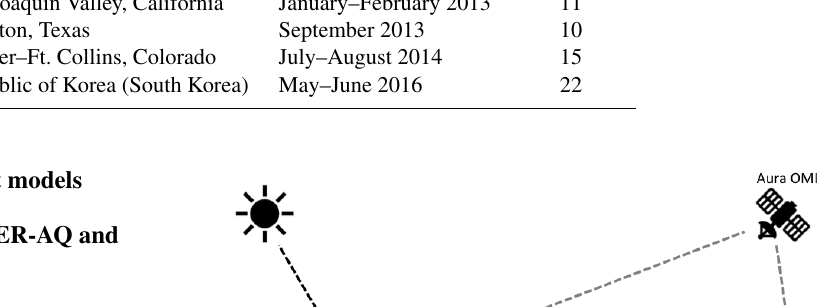
Table 1. Campaign locations and time periods. Campaign Location Time period DISCOVER-AQ